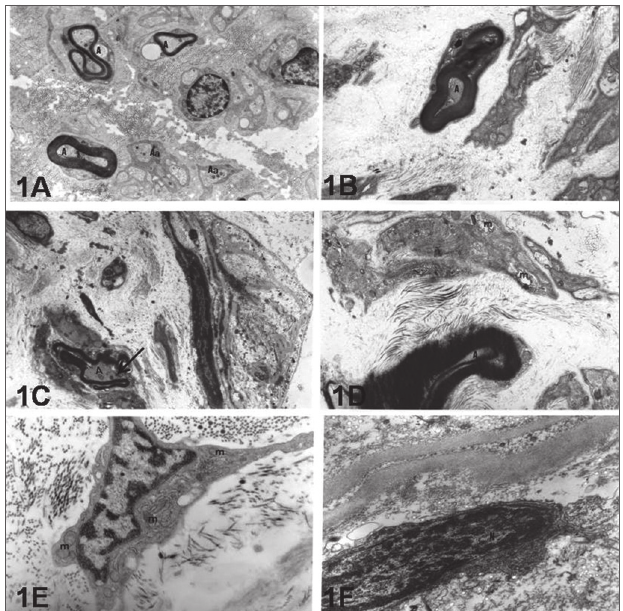
Figura 1. Micrografias eletrônicas mostrando partes de nervos faciais intratemporais de indivíduos com paralisia facial idiopática (A, C e E) e sem paralisia facial (B,D e F). Observar em 1A axônios mielinizados (A) e amielínicos (Aa), em 1C descontinuidade da bainha de mielina (Seta) e, em 1E fibroblasto típico indicando intensa atividade de síntese (m=mitocôndrias). Em 1B observar axônio (A) revestido por lamelas de mielina desarranjadas (Seta). Em 1D célula de Schwann contendo mitocôndrias (m) com sinais de cristólise. Em 1F fibroblasto com núcleo heterocromático (N) indicando baixa atividade de síntese. A, B e C = 12.000X; D, E e F =